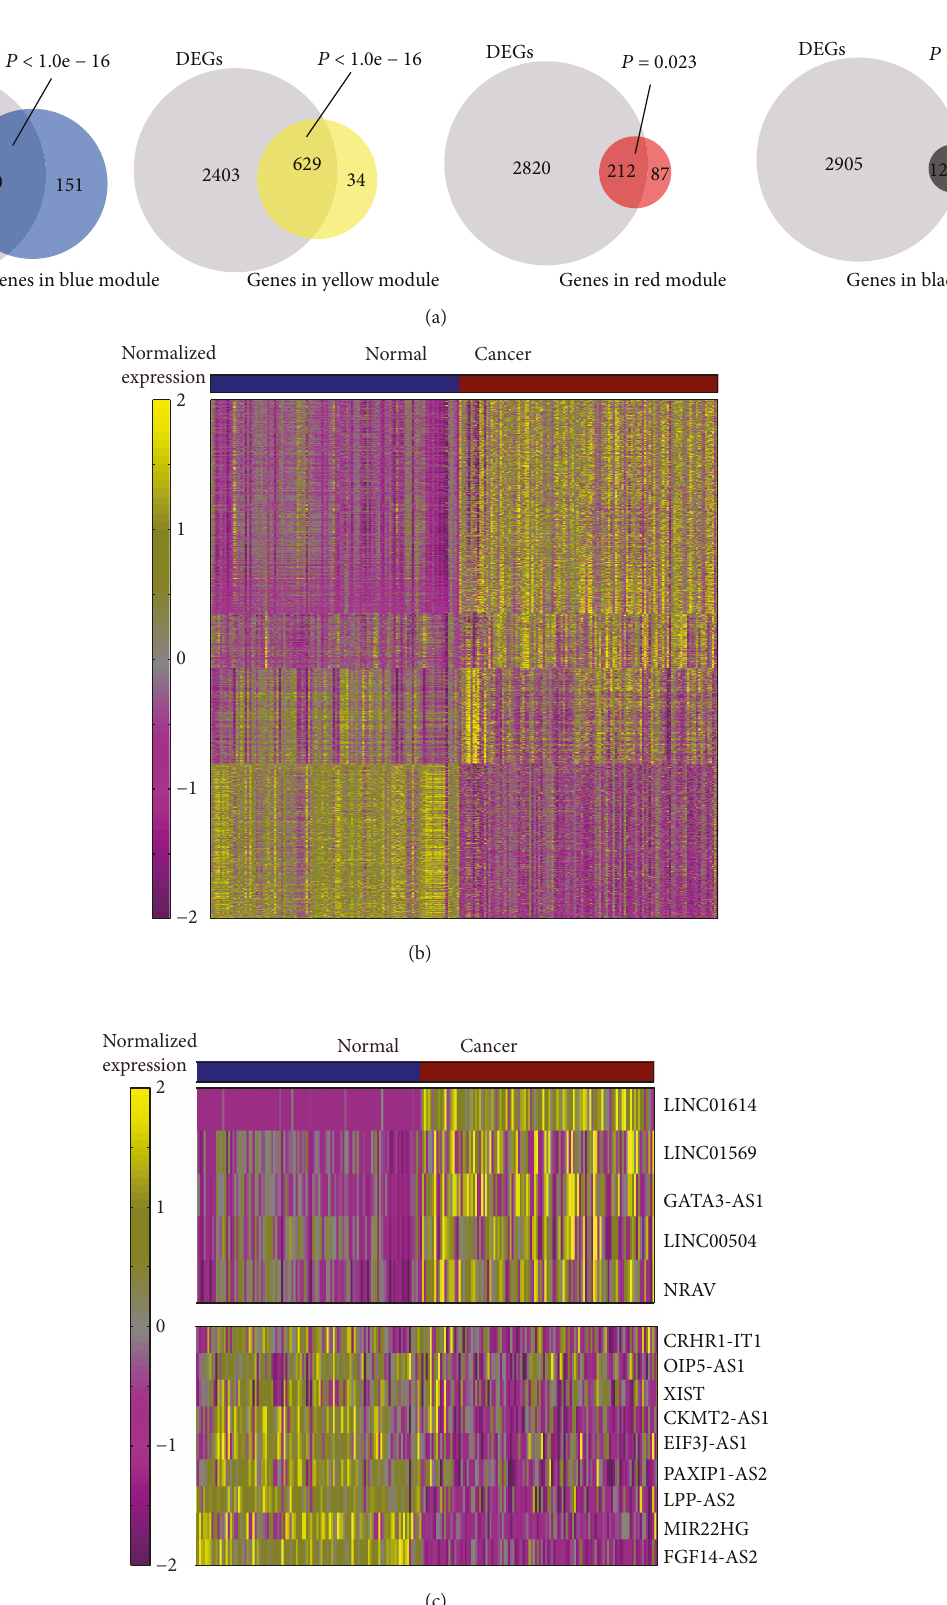
Figure 2: Di ff erential genes of breast cancer in the modules. (a) Overlapped genes of each module and DEGs. The genes in the blue, yellow, red, and black modules are signi fi cantly overlapped with DEGs. (b) The expression heat map of DEGs in the blue, yellow, red, and black modules. (c) Expression levels of 5 upregulated lncRNAs in cancer relative to normal tissue (up) and 9 downregulated lncRNAs